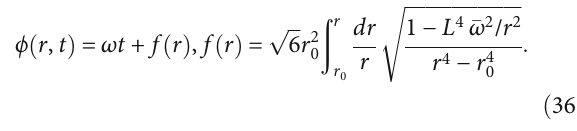
Figure 2: The behavior of the derivative of the D5-brane world volume fi eld with respect to r with L = 1, r (blue-dashed), ω = 8 (gray-dashed), and ω = 10 (black-dashed) (up-left). [Up-Right] The behavior of the g induced world volume metric with L = 1 , r = 0 , ω = 0 (black-solid), r = 1 : 5 , ω = 0 (gray-dashed), and r 0 0 [Down-Left] The behavior of the world volume Hawking temperature of the probe D5-brane with r = 3 : 5 (gray-dashed), r = 3 (blue-dashed), and L = 10 . [Down-Right] The behavior of the energy density of the probe D5-brane dashed), r 0 0 = 4 (black-solid), r = 6 (blue-dashed), and r = 8 with L = ω = 1 and r 0 0 0 ffiffiffiffiffiffiffiffiffiffiffiffiffiffiffiffiffiffiffiffiffiffiffi